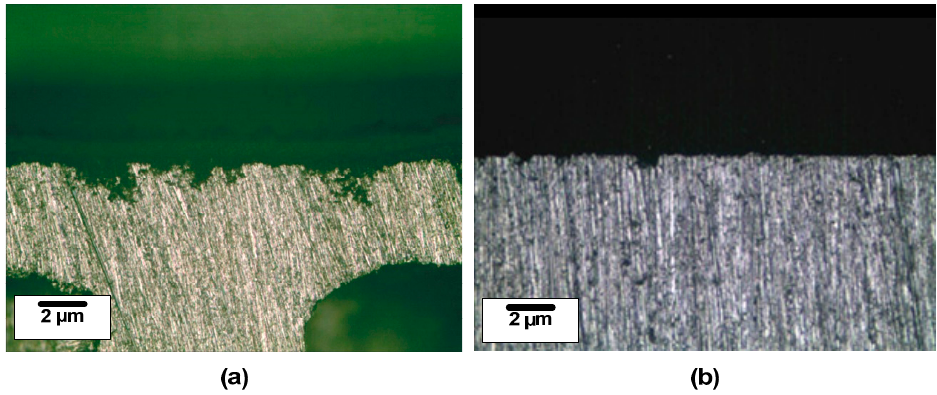
Figure 4. Cross-sectional images of ( a ) A1070 and ( b ) U1070 after the polarization tests.